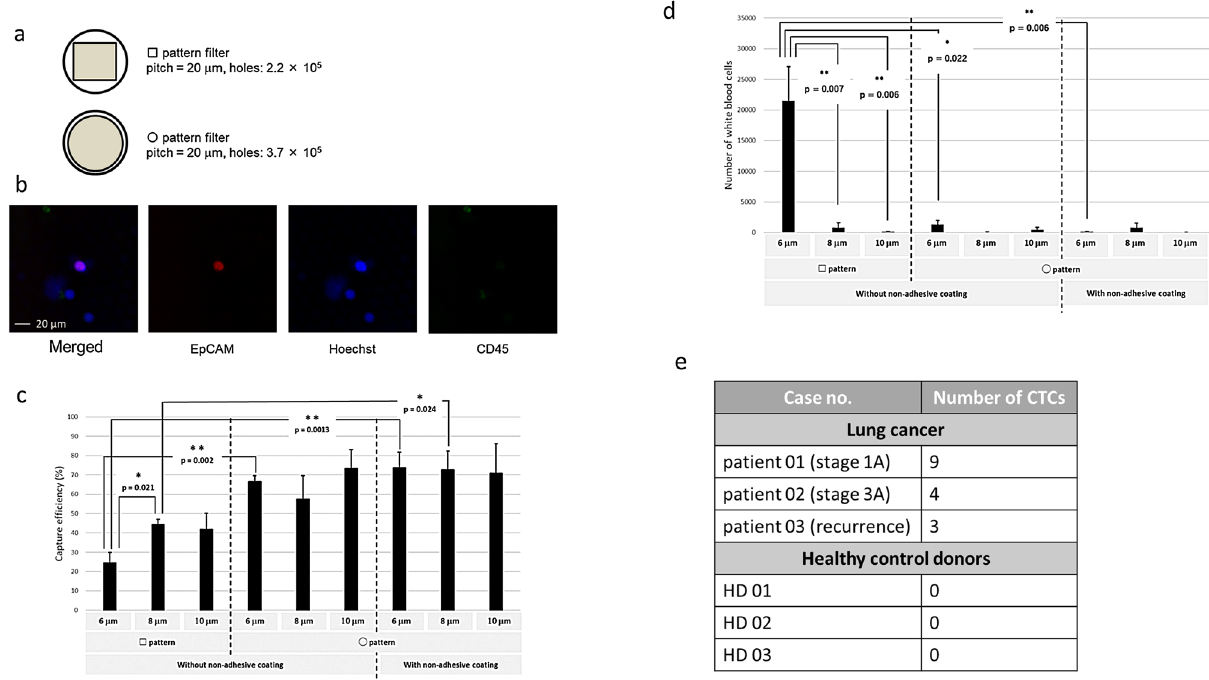
Figure 3. CTC capture test using the glass filters. ( a ) Schematic of the various glass filters. ( b ) CTCs captured on a glass filter. ( c ) The CTC capture efficiency of various glass filters. ( d ) Cell counts of white blood cells on the various glass filters. ( e ) Numbers of captured CTCs on glass filters from the blood of lung cancer patients and healthy control